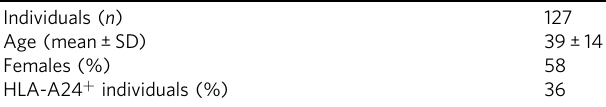
Table 1 Summary LIFT cohort.